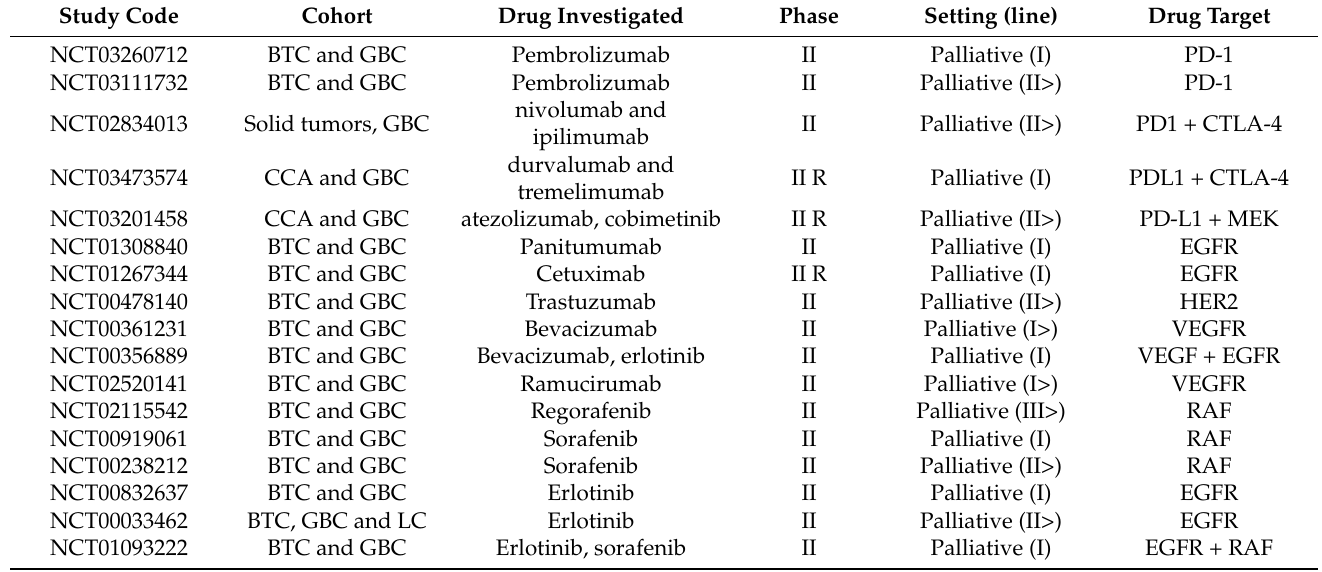
Table 1. Representative ongoing clinical trials involving advanced gallbladder cancer patients and testing the efficacy of targeted therapies or